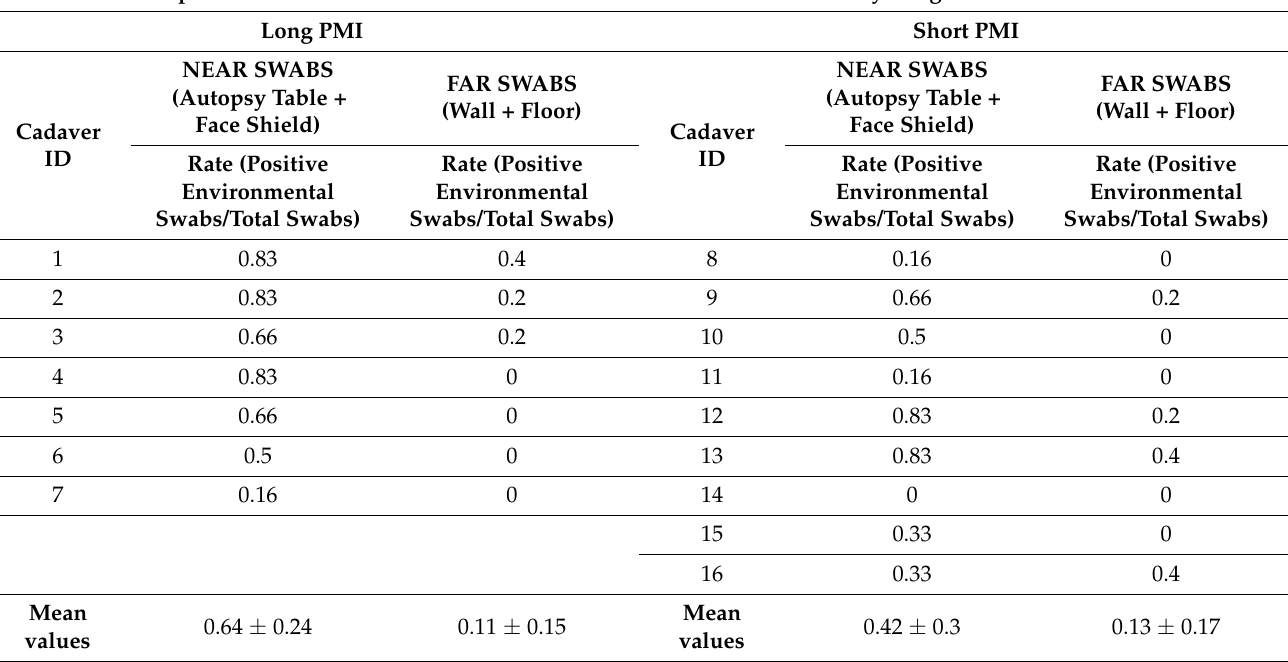
Table 3. All environmental swabs collected at T1 were split into two groups: “Short PMI” and “Long PMI”. Moreover, the same groups were divided into two subgroups: Near swabs (all swabs collected on the FS and on the AT) and far swabs (all swabs collected on the walls and on the floor).